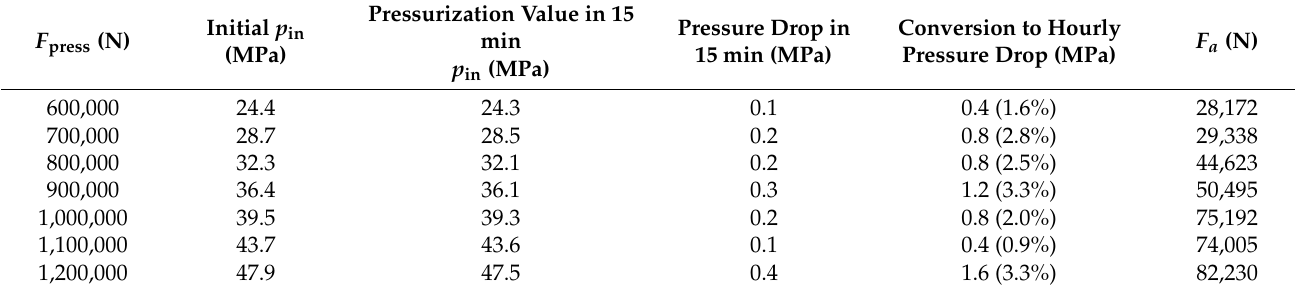
Table 6. The inner cavity pressure sealing test data of connector contact sealing theory verification.